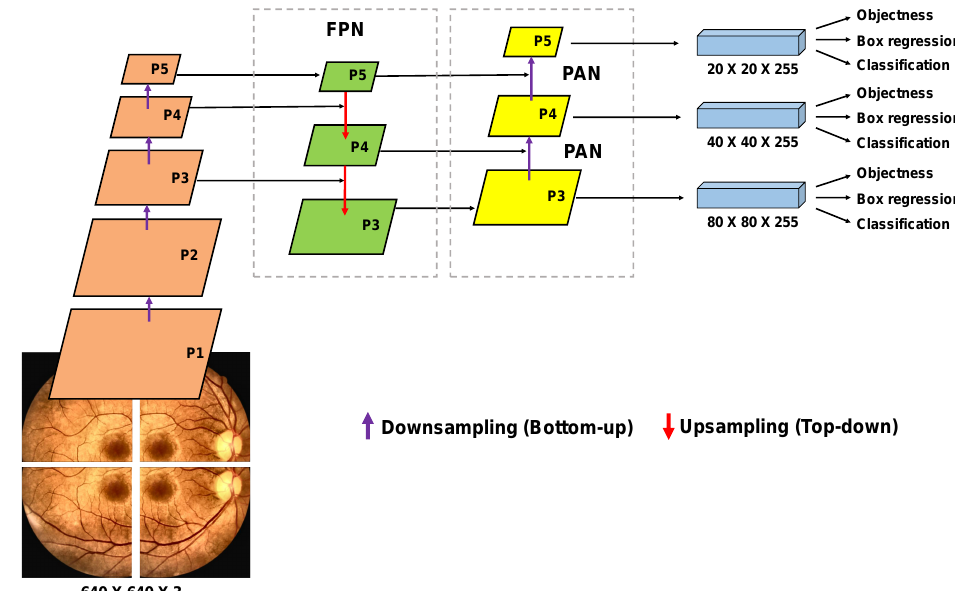
Figure 4. FPN + PAN structure used in the Neck of the neural network architecture of the proposed approach. FPN has a Top-Down structure and lateral connections that enable it to build feature maps with high-level semantic meaning, which are used to detect objects at different scales. The PAN architecture conveys strong localization features from the lower-feature maps to the upper-feature maps ( Bottom-up ). The two structures combined to reinforce the ability to merge characteristics of the Neck structure. The detection of lesions is performed in layers P3, P4 and P5 of the FPN + PAN structure, having outputs with sizes of 80 × 80 × 255, 40 × 40 × 255 and 20 × 20 × 255, respectively. FPN, Feature Pyramid Network; PAN, Path Aggregation